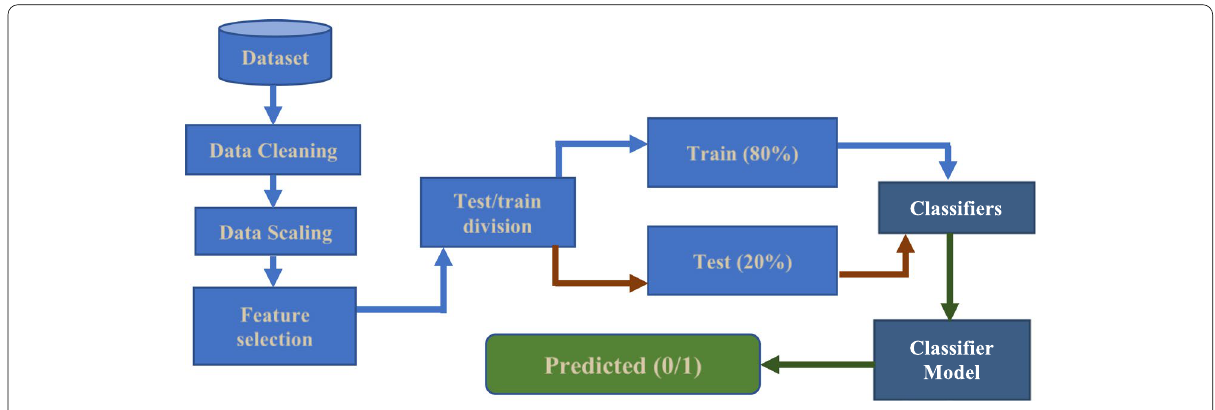
Fig. 1 Model for Classification where 0 is non‑T2DM and 1 is